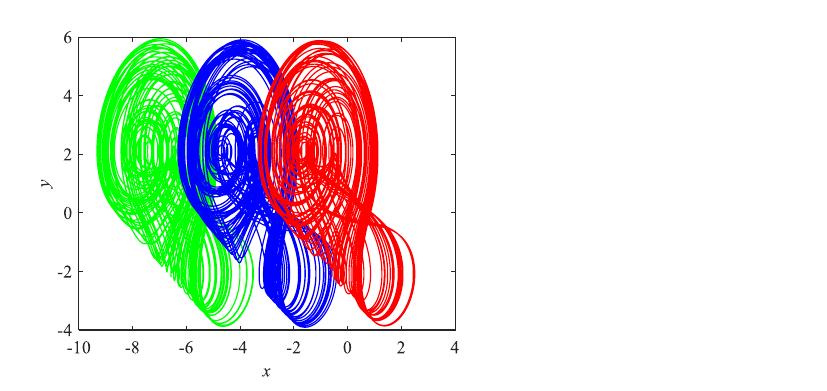
Figure 15. Offset boosting with control parameter p . p = 3 (green), p = 0 (blue), p = − 3 (red).